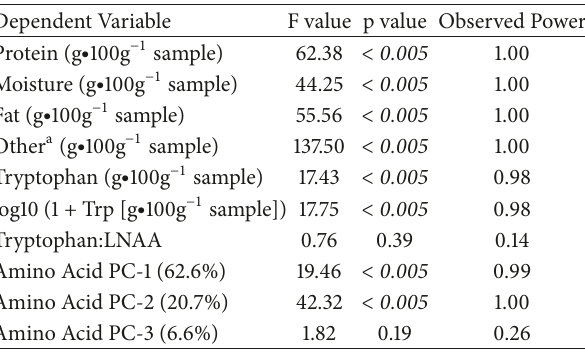
Table 7: 1-Way ANOVAs Comparing Wild and Processed Meat. Dependent Variable